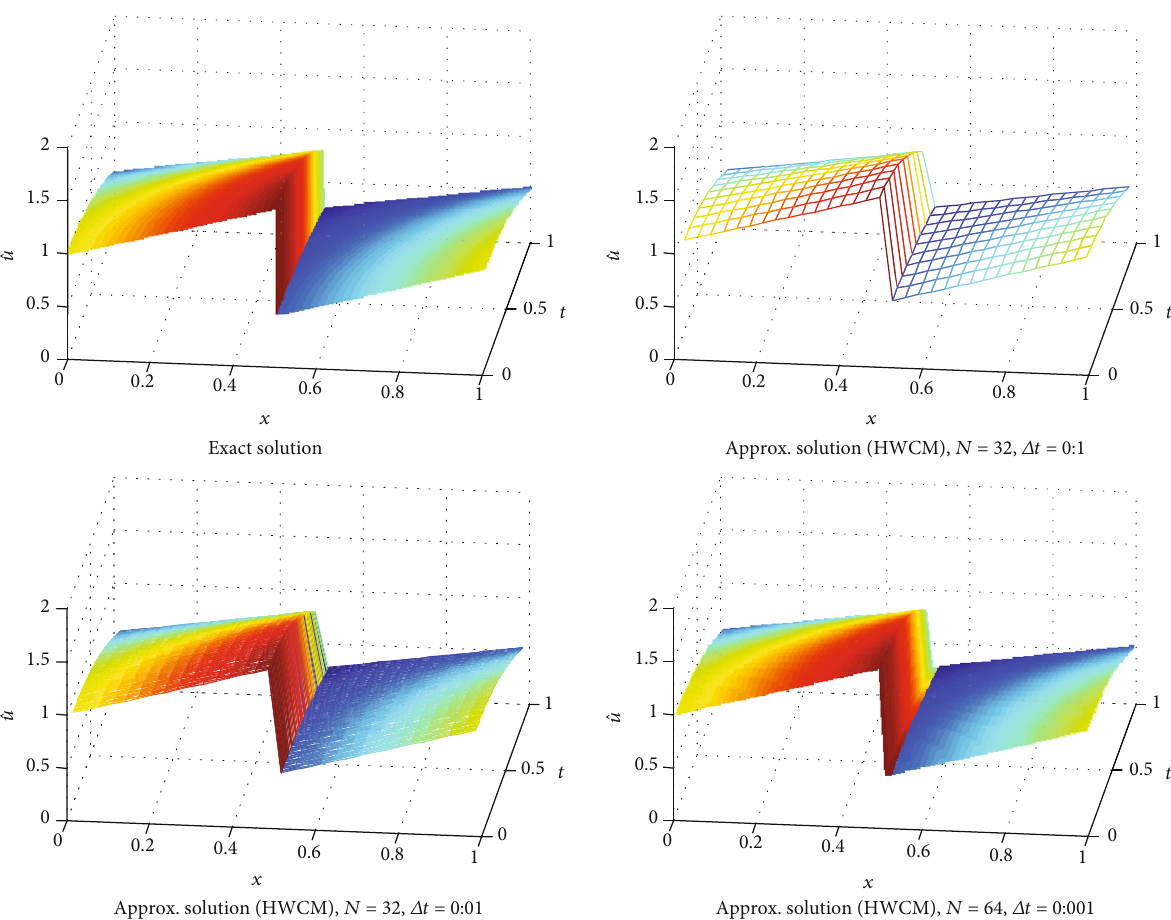
Figure 4: Comparability of exact and estimated results for Example